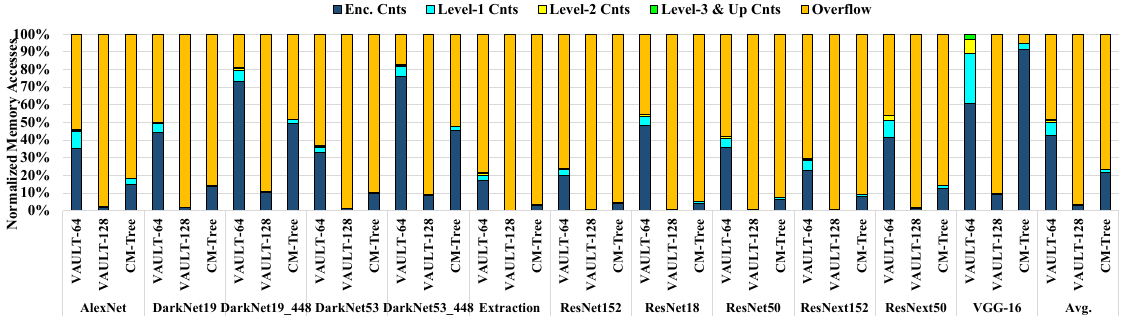
Figure 12. Extra memory traffic for VAULT-64, VAULT-128, and